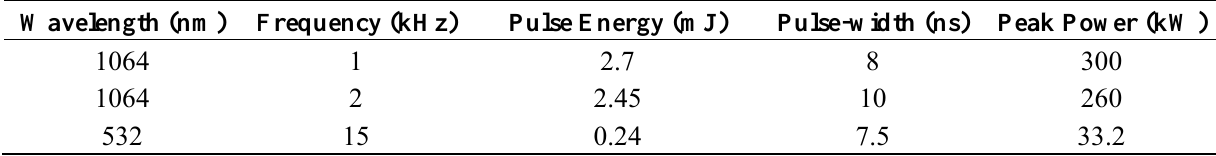
Table 2. Laser beam characteristics used to machine the substrates.